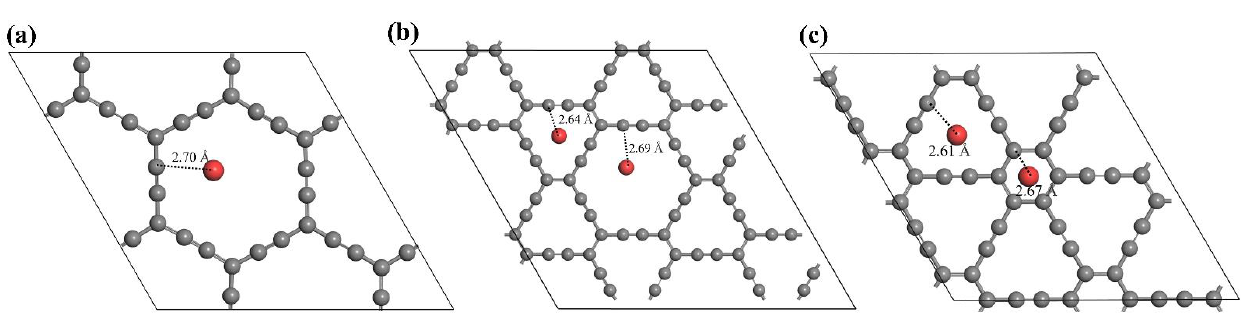
Figure 1. Optimized structures of a single Na atom adsorbed in 2D ( a ) αGy, ( b ) βGy, and ( c ) γGy. Next, we explored the adsorption of a single Na on GyNTs. Our previous work sug- gested that curvature can cause differentiations of sp- and sp 2 -C atoms [41], inducing more possible adsorption sites. These sites include the top site (t) on single C atoms, the bridge site (b) between two bonded C atoms, and the hollow sites of acetylenic rings (denoted H or h depending on pore size), as illustrated in Fi gure 2. We used the superscript (’) to represent concave cases. A Na atom was placed at these positions at initial distances of about 1.8 Å , and full relaxations were performed. For α GyNTs, there is no distinction be- tween H α and H α ’ because the hexagonal a cetylenic rings are large enough to anchor a Na at the center regardless of tube size ( n ). Figure 3a shows the E b of a single Na on α GyNTs as a function of tube size ( n ). The E b values of both ( n , n ) and ( n , 0)- α GyNTs increases with tube size, gradually converging to − 2.02 eV. It is also evident that the E b values of both ( n , n )- α GyNTs are always larger than that of ( n , 0)- α GyNTs because ( n , n ) α GyNTs have a larger radius.